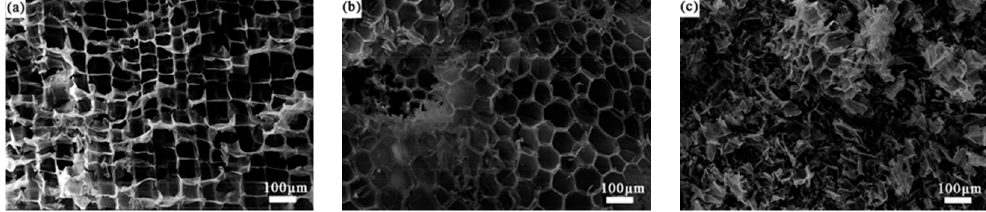
Figure 6. SEM images of radial section ( a ), tangential section ( b ), and powder of ML ( c ).